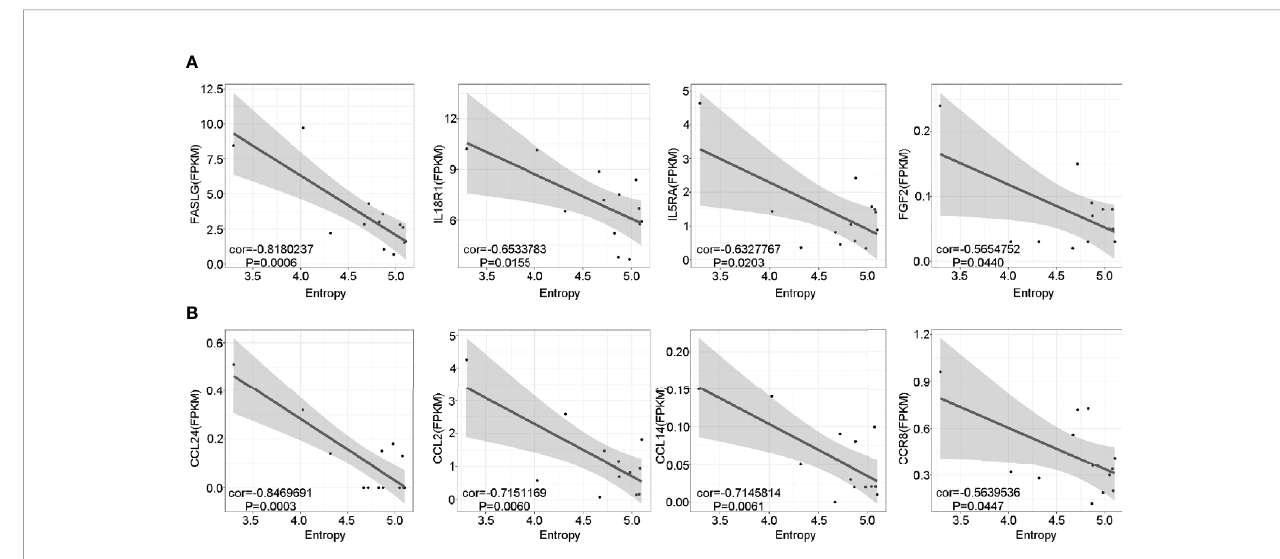
FIGURE 6 | Lower TCR diversity was correlated with in fl ammation and chemotaxis in pGD. (A, B) The correlations of TCR Entropy with the expression of (A) in fl ammation (B) chemotaxis associated genes in pGD patients (N = 13) by linear regression analysis using Pearson method. The gray zone represented 95% con fi dence intervals. Texts denoted in the left bottom corner were the correlation coef fi cient (cor) and P value. pGD, persistent Graves ’ disease; TCR, T cell